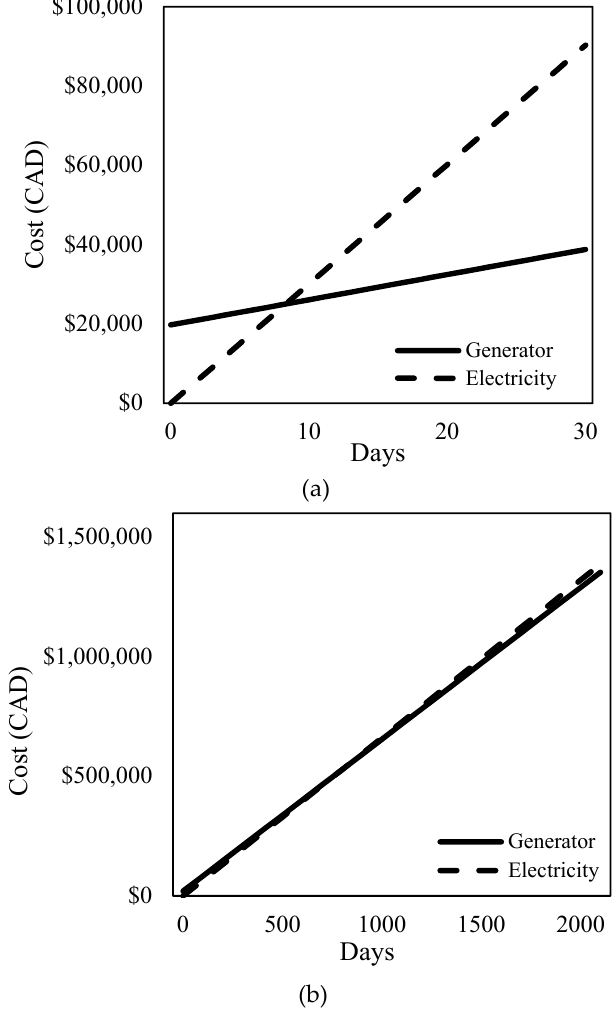
Figure 6. Cost of diesel generator vs. electrical power in (a) Resolute and (b) ON. Table 13. Operational costs for 96 ´ × 30 ´ greenhouses.